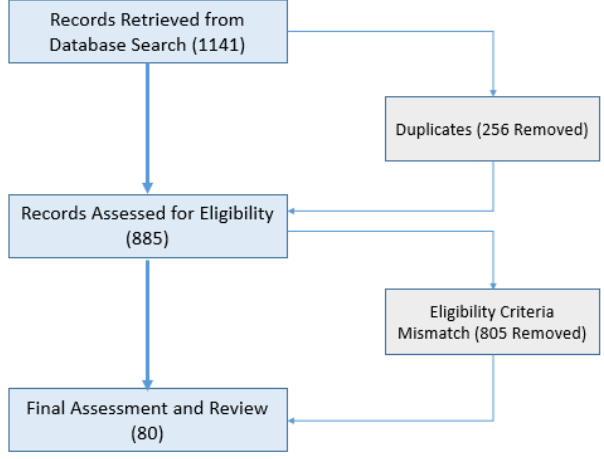
Figure 3. Screening process for the